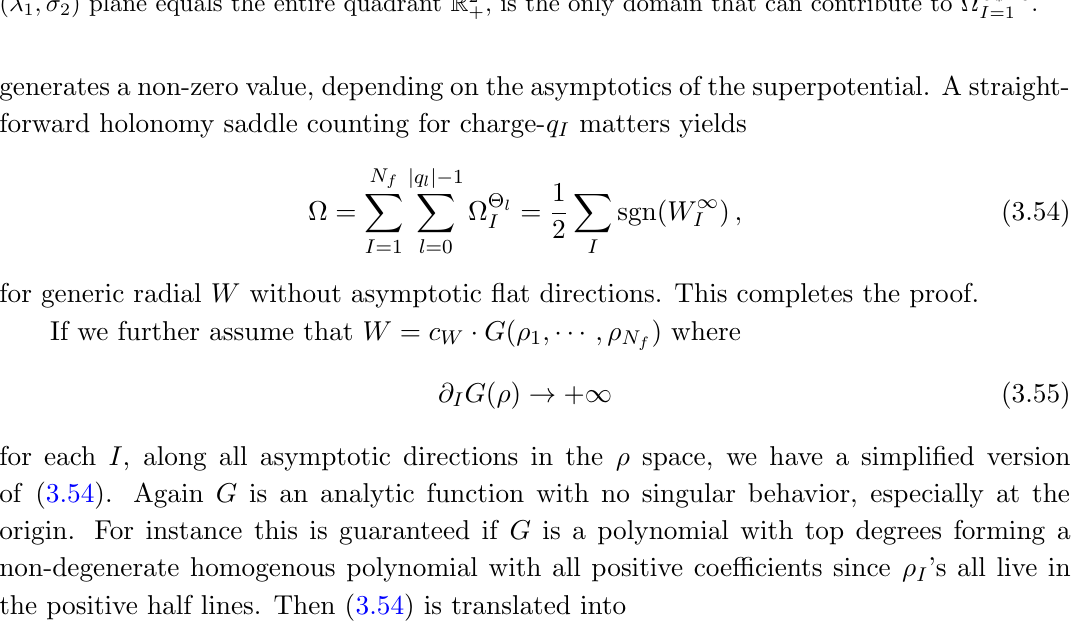
= @Y , generally, @ (cid:1) ( a ) I 6 (cid:1) ( a ) I